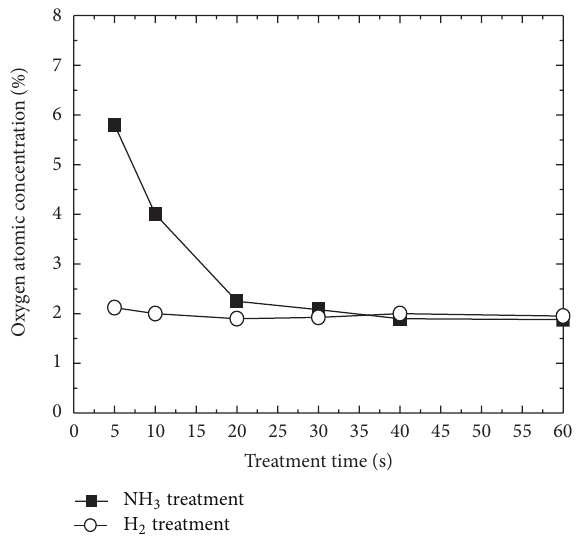
Figure 2: Oxygen atomic concentration at the Cu/SiN interface for H 2 and NH 3 plasma treatments as a function of treatment time.